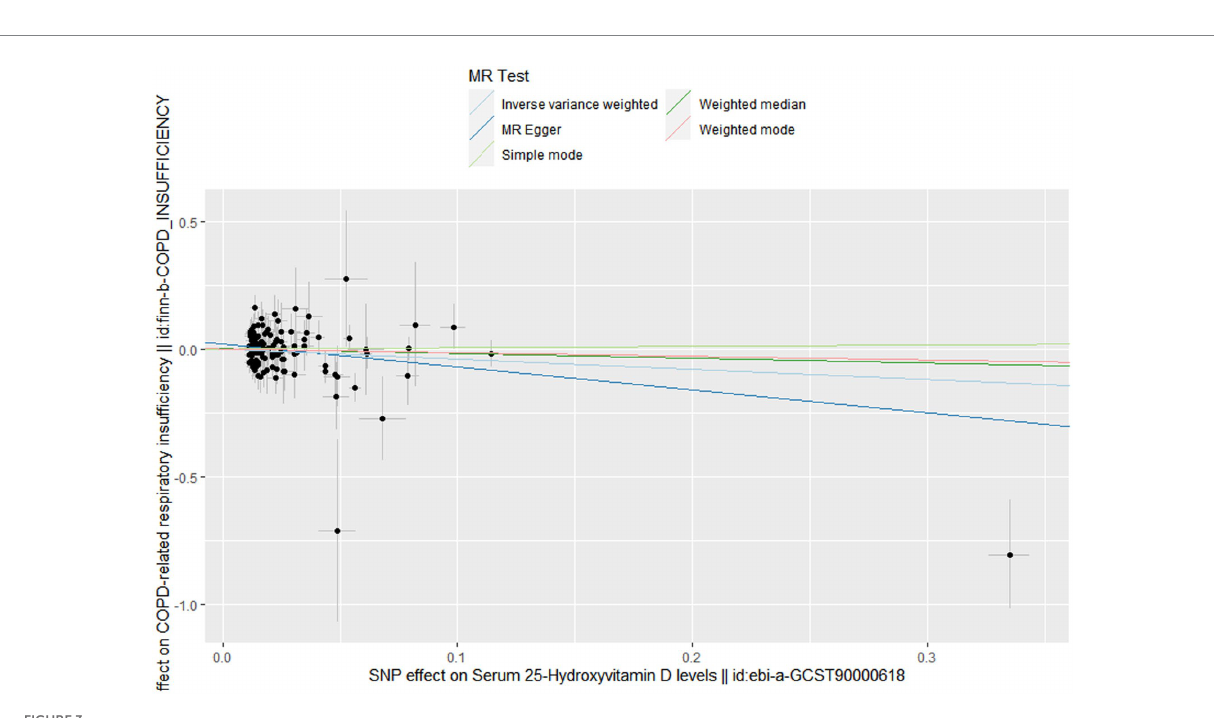
FIGURE 3 Scatter plot to visualize causal effect of Vitamin D on the risk of chronic obstructive pulmonary